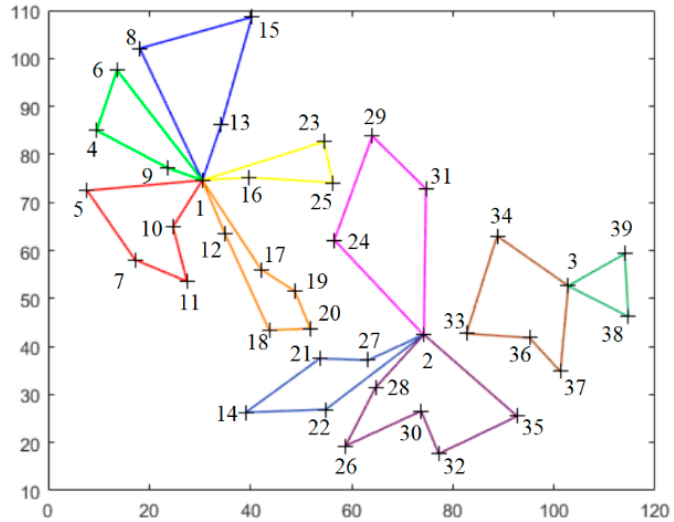
Figure 9. The agricultural machinery scheduling path of the first stage.